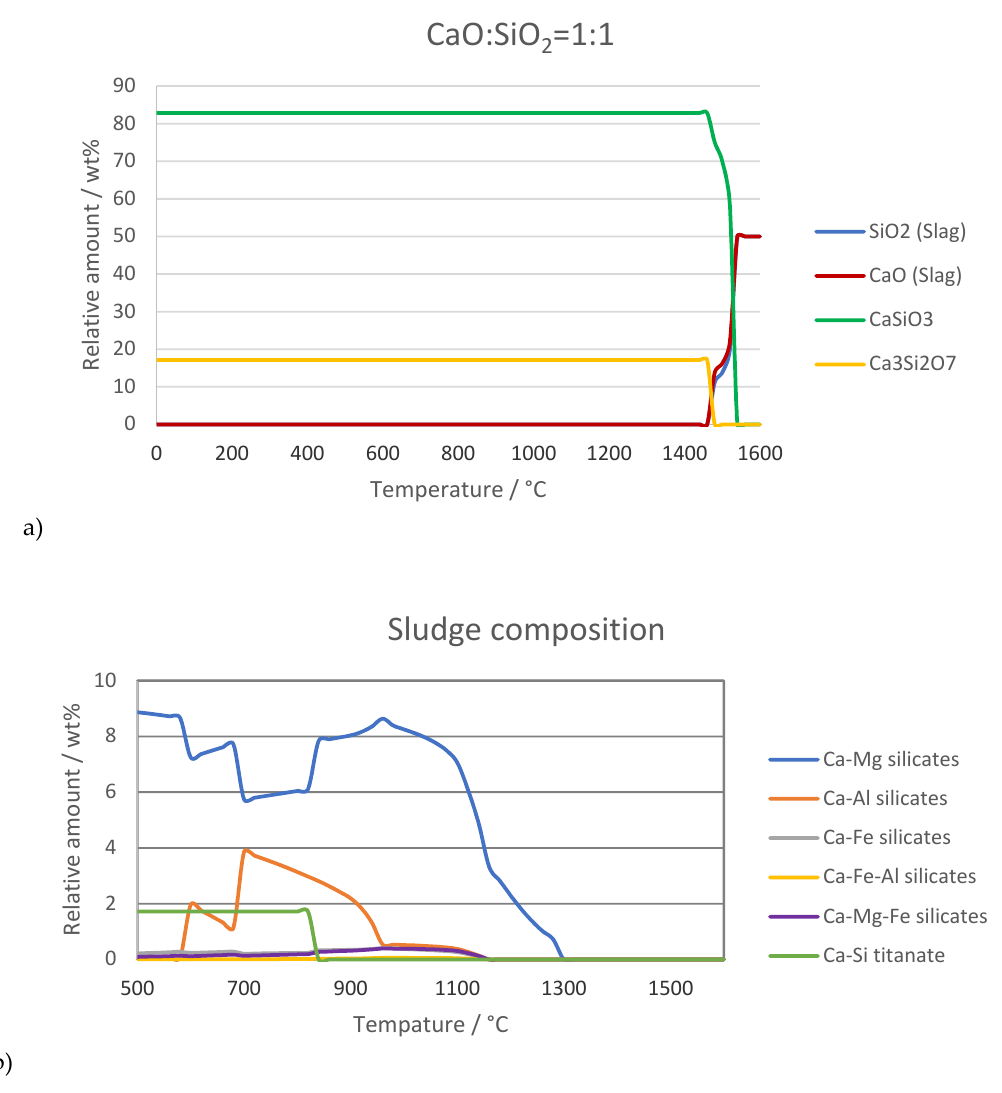
Figure 4. FactSage™ equilibrium calculations of CaO–SiO 2 mineral phases: ( a ) calculation of equal composition of CaO:SiO 2 , ( b ) calculation using the sludge composition (Table 2).